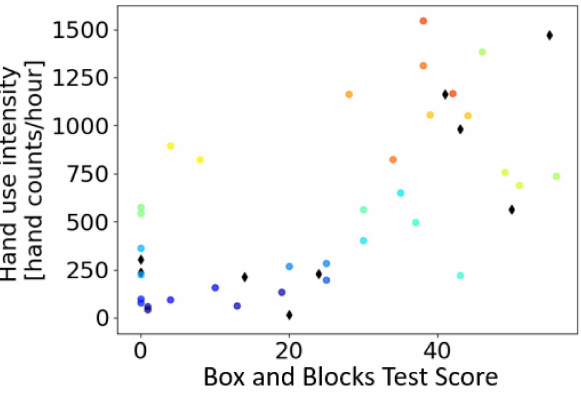
Figure 8. Testing the use capacity Threshold Hypothesis for the stroke-affected hand. Shown is hand use intensity measured at home for 29 individuals with a stroke with different levels of hand functional capacity, as quantified by the Box and Blocks Test (BBT) score. For the circles, each color represents one subject, and each subject can have one to three samples for up to three different days. For the diamonds, each data point is a different subject, and data was acquired with a previous version of the system sampled at 30.3 Hz instead of 52.6